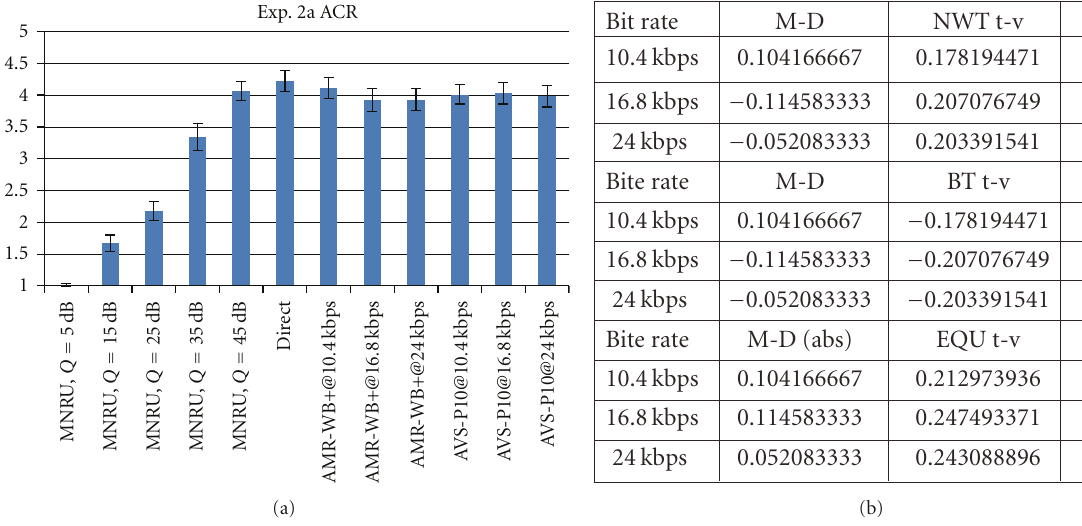
Figure 12: Experiment 2a MOS scores statistic analysis result and T -test